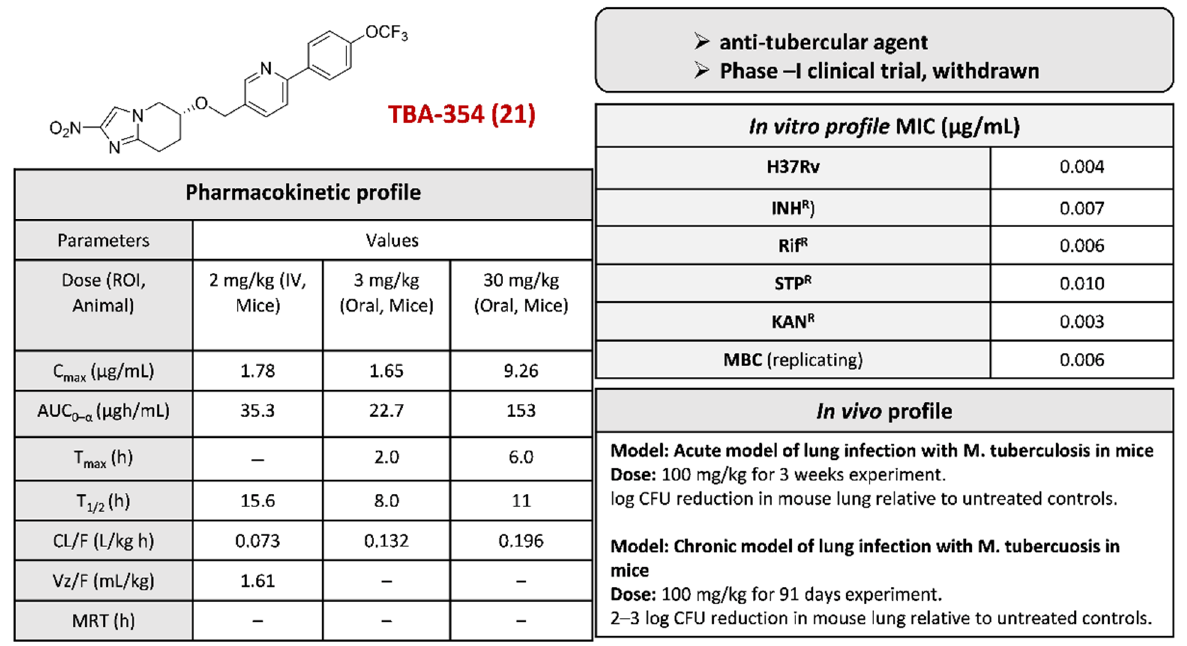
Figure 25. Activity profile of TBA-354 21 [188].